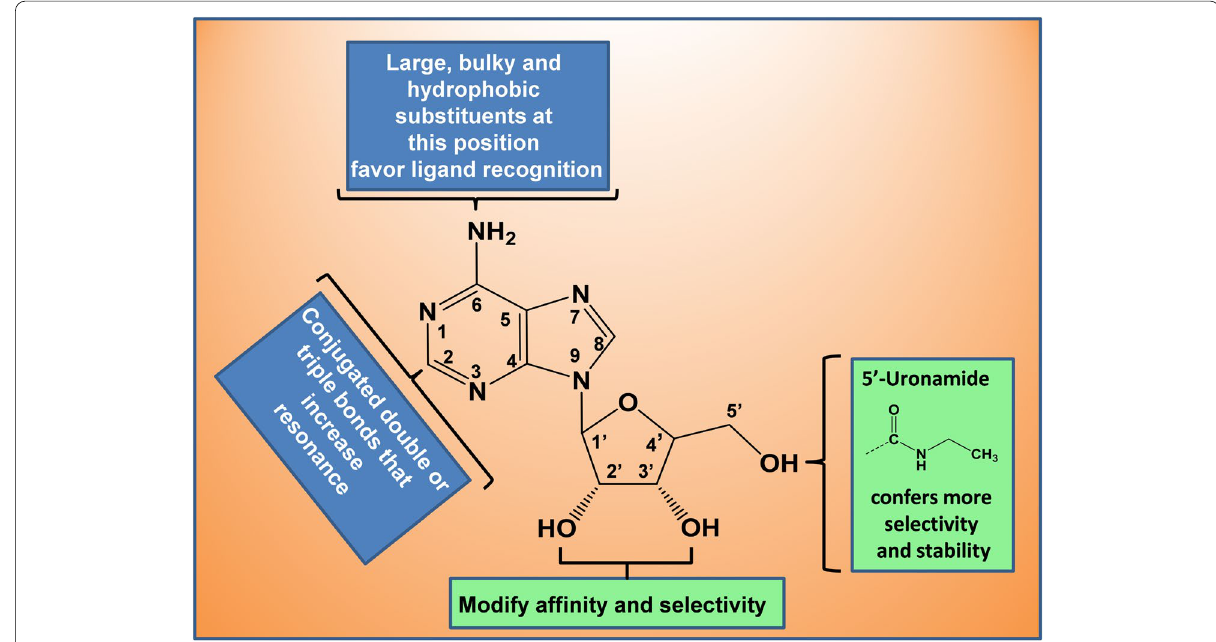
Fig. 6 Relevance of the different ADO chemical substitutions for ADORA